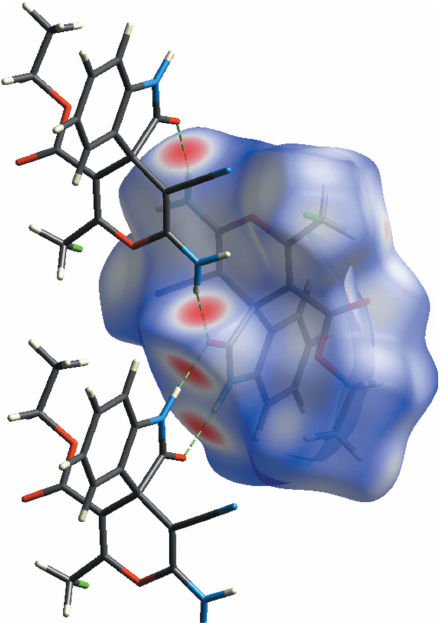
Figure 5 Hirshfeld surface of the title compound mapped with d norm in the range (cid:4) 0.6053 to 1.4079 a.u.